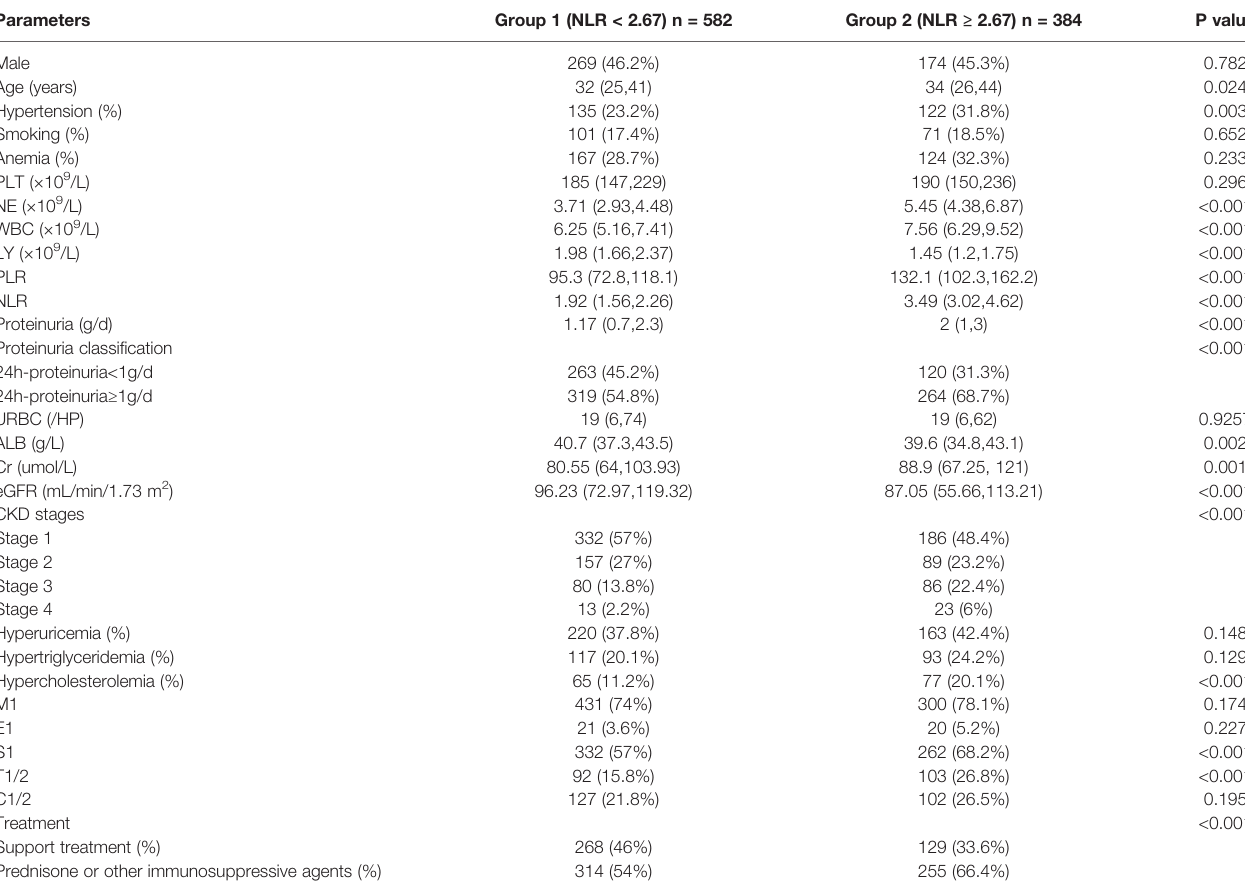
TABLE 2 | Demographic and clinicopathological characteristics of 966 IgAN patients.